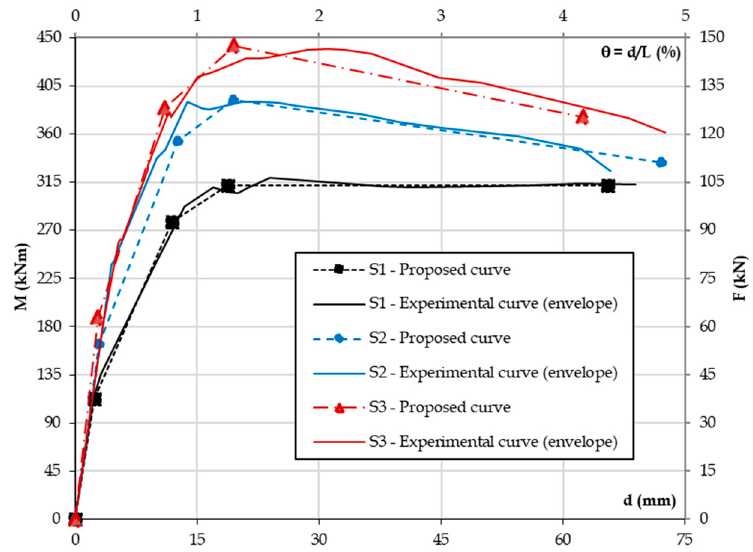
Figure 20. Experimental envelope response and proposed multilinear diagram—Specimen S1, S2, and S3.